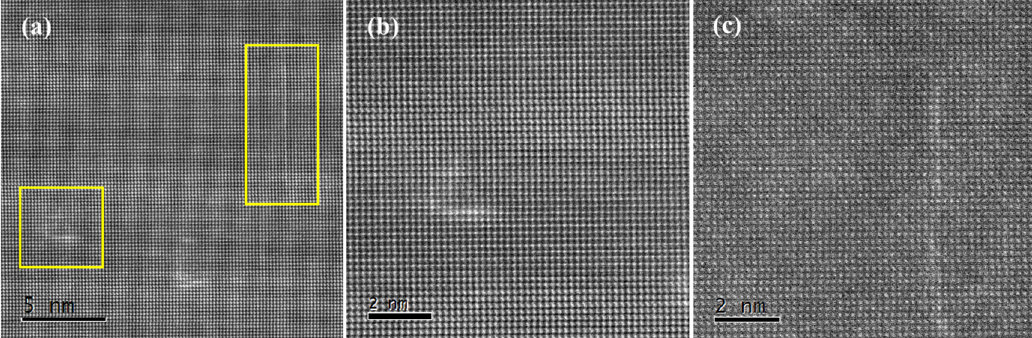
Figure 5. ( a ) HAADF-STEM image of the GP zone after aging for 1 h, and ( b , c ) enlarged images of the rectangular areas in ( a ), [001] (cid:2885)(cid:2922)